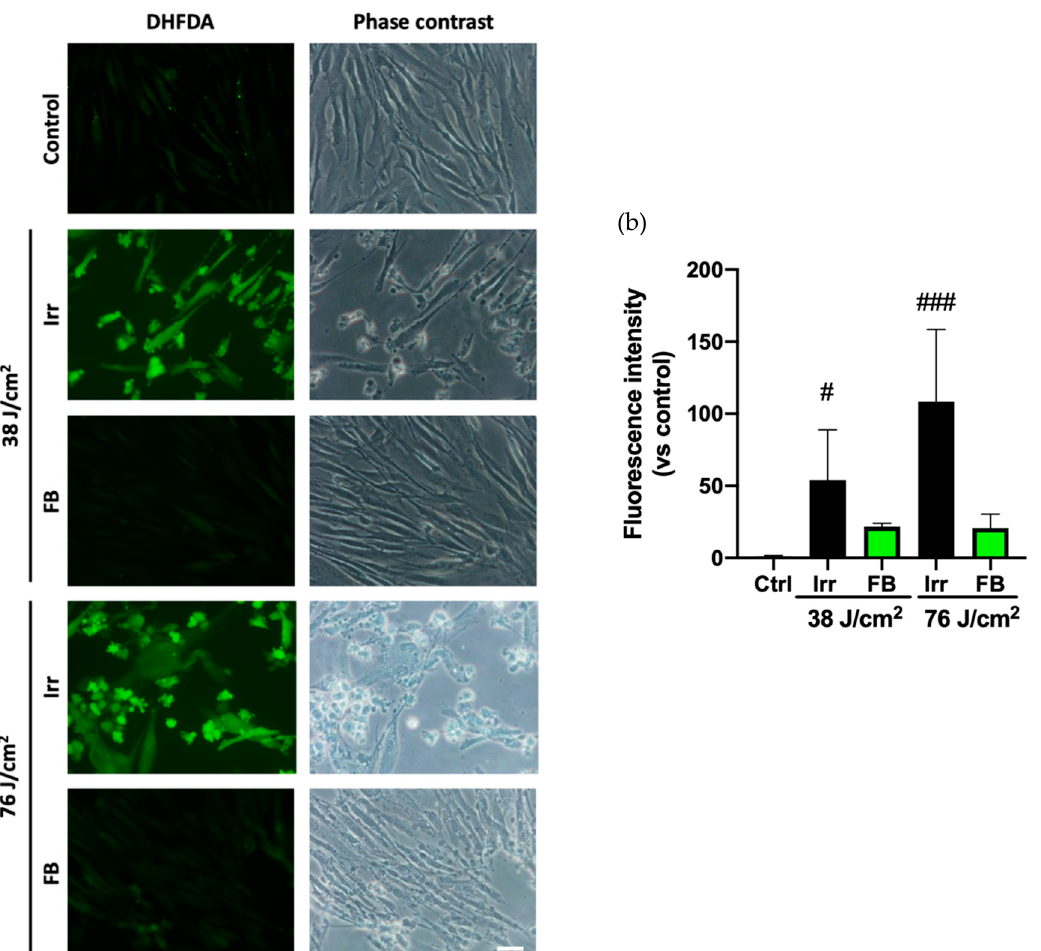
Figure 2. Oxidative stress in HDF exposed to artificial blue light and effect of pre-treatment with FB. Oxidative stress was evaluated by the dihydrofluorescein diacetate (DHFDA) assay. Cells were incubated with FB 0.5 mg/mL for 24 h, loaded with DHFDA, exposed to 38 and 76 J/cm 2 of blue light radiation, washed, and observed immediately under the microscope ( a ). Quantification of DHFDA fluorescence was measured using ImageJ ( n = 4). Data are shown as mean ± SEM ( b ). # p < 0.05, ### p < 0.001 vs. control. Scale bar: 50 µm.